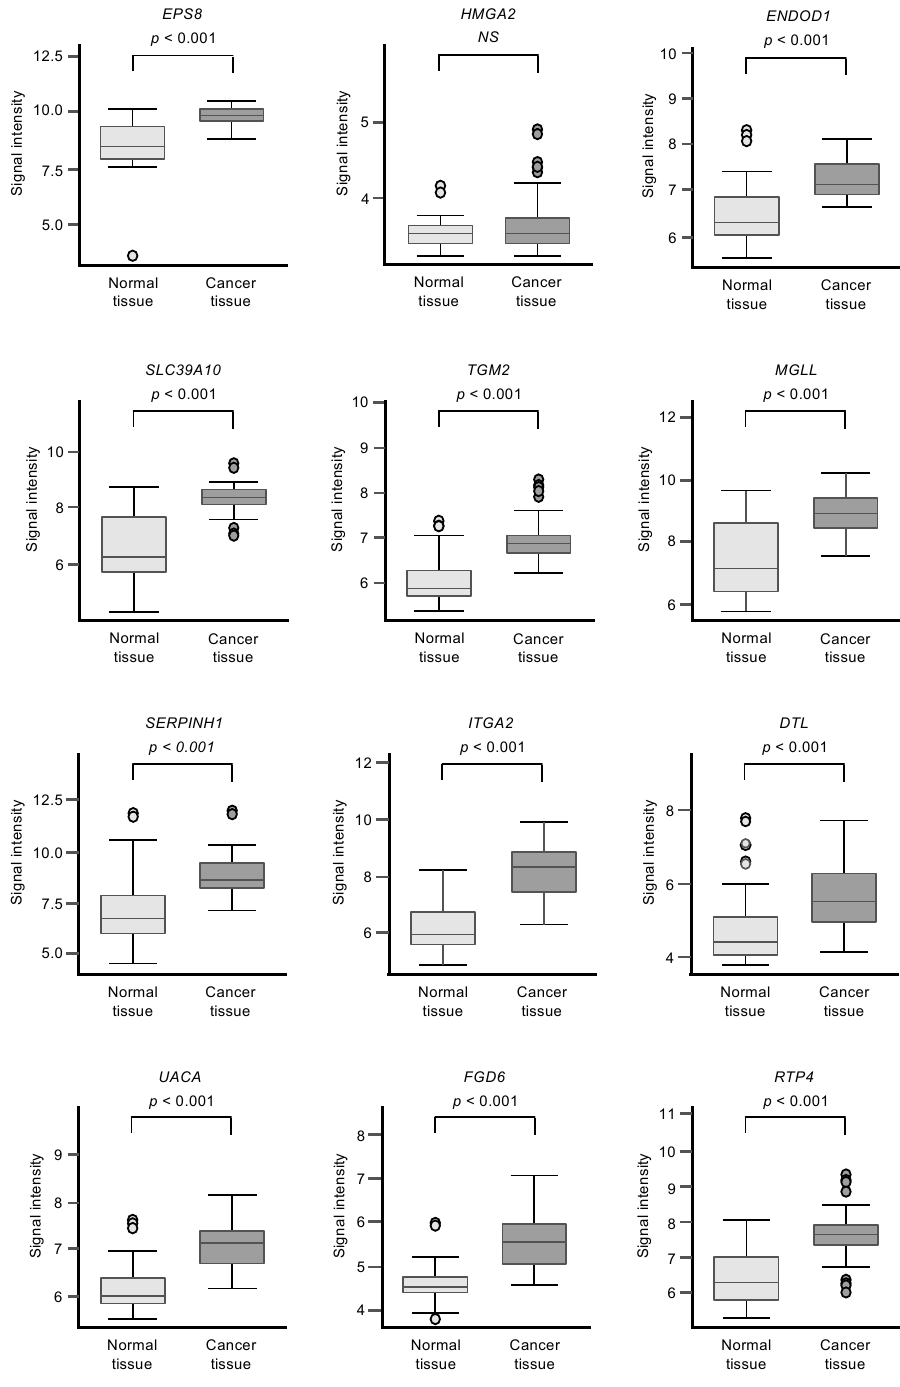
Figure 3. GSE15471 dataset analyses of the expression levels of 12 genes (predicted 5-year survival) that are targets for miR-30a-3p regulation in PDAC clinical specimens.